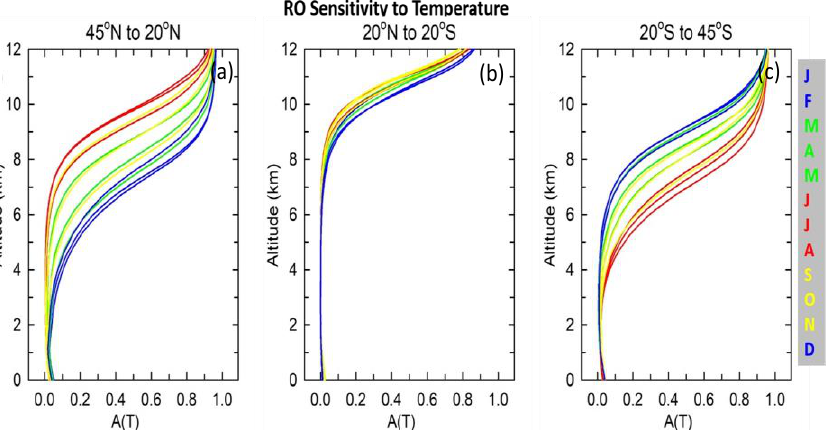
Figure 6. RO sensitivity to the atmospheric temperature: ( a ) northern mid-latitudes 45 ◦ N to 20 ◦ N, ( b ) tropics 20 ◦ N to 20 ◦ S, ( c ) southern mid-latitudes 20 ◦ S to 45 ◦ S. Each panel presents 12 monthly profiles, seasonally colored.